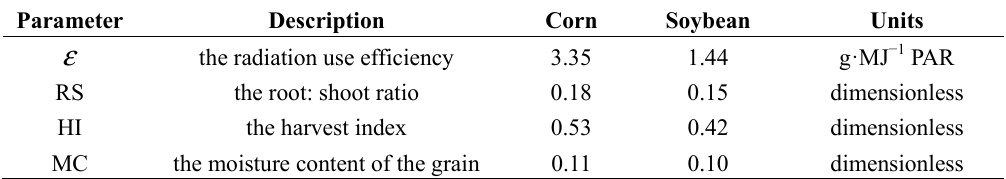
Table 2. The parameters used in our study for estimating crop